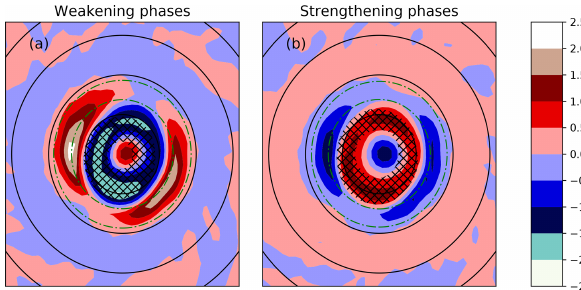
Figure 17. Composite PV tendencies (PVUh − 1 shading) at 1532m across all weakening and strengthening phases in the five ensembles with distinct intensity fluctuations. Green dashed lines show the full range of RMWs at the same level. Hatching indicates regions where the average PV exceeds 30PVU. Black circles show 25km radial